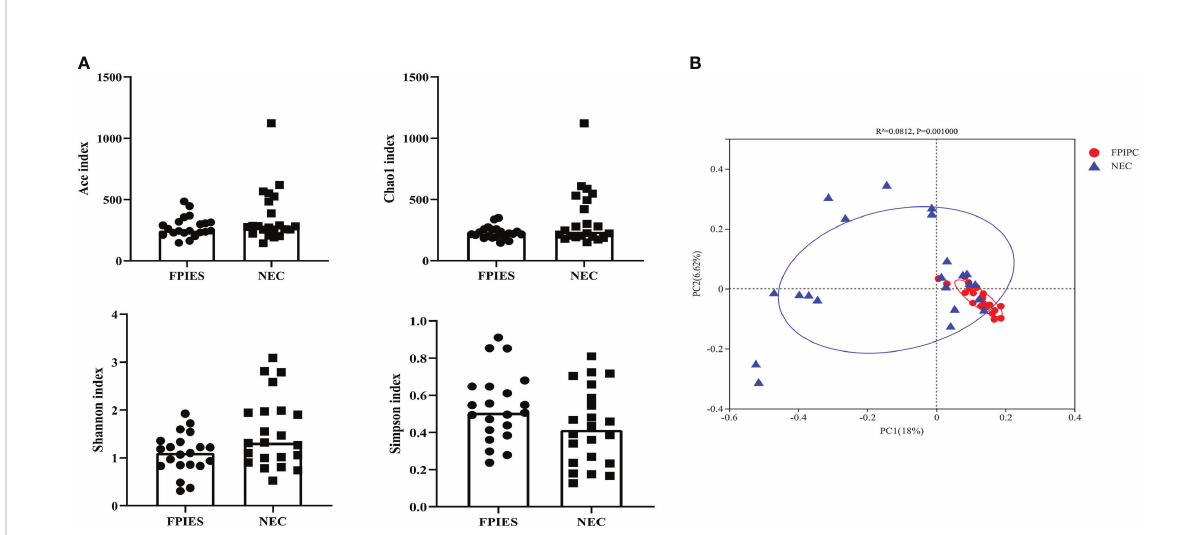
FIGURE 3 Alpha and beta diversity between the necrotizing enterocolitis (NEC) and food protein-induced allergic protocolitis (FPIAP) groups. There were no signi fi cant differences between the NEC and FPIAP groups in the ace index, Chao1 index, Shannon index, and Simpson index ( P >0.05). (A) There was a signi fi cant difference in beta diversity between the NEC and FPIAP groups ( P <;0.05). (B) N =22 for NEC and N =21 for